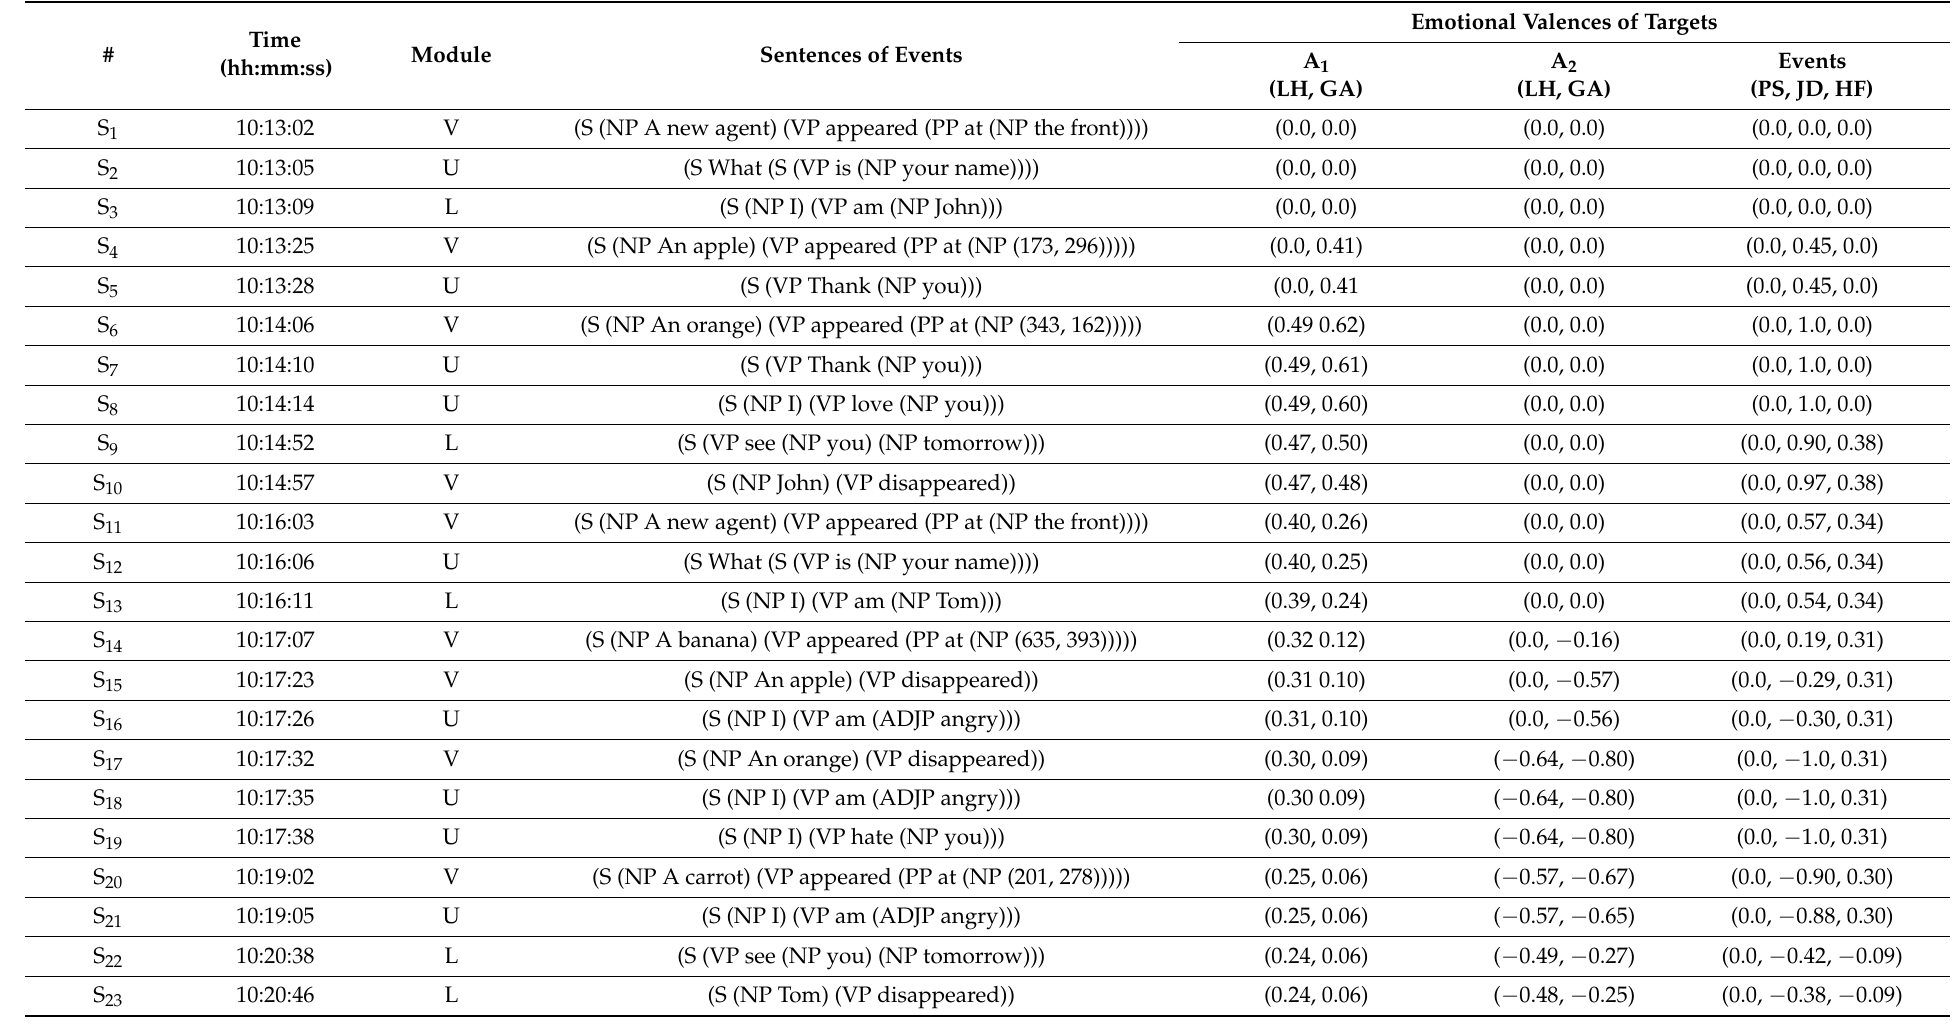
Table 7. The sentences of the events and emotional valences stored in the sentential memory. (V: vision module, L: listening module, U: utterance